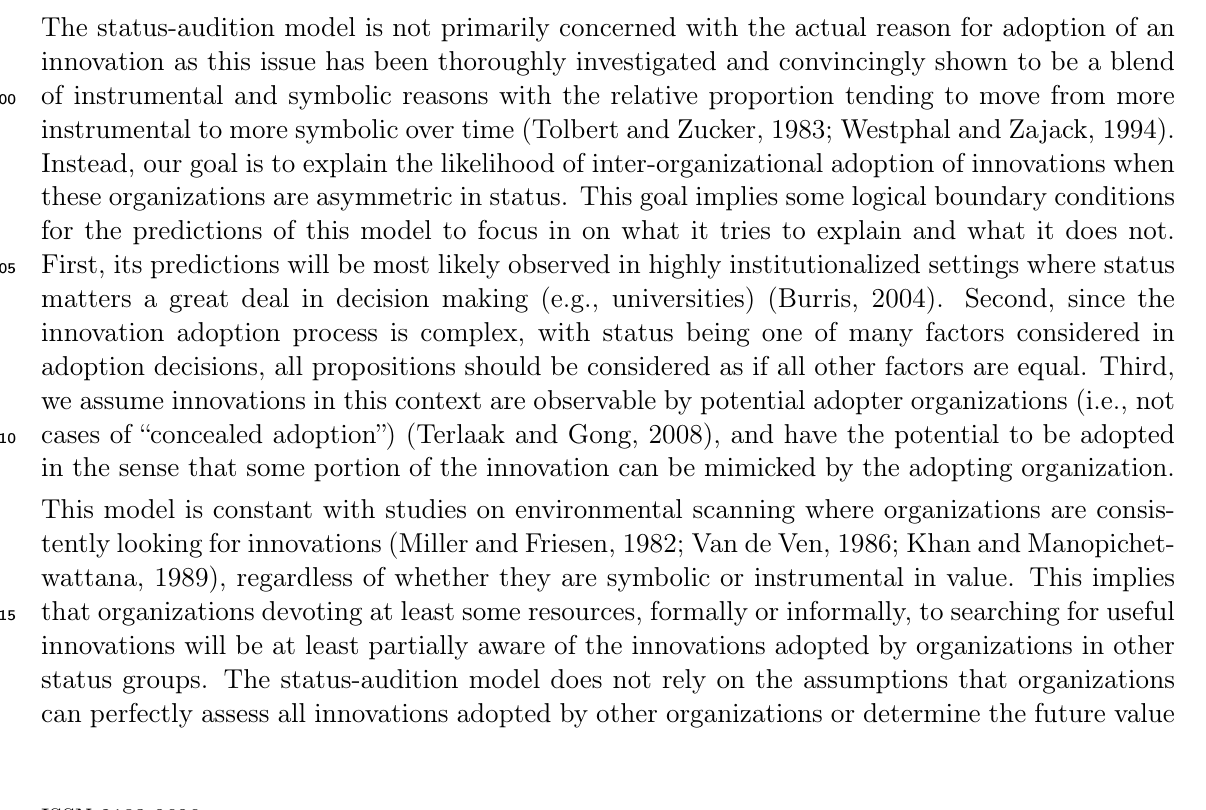
Fig. 1. Status-Audition Model (Partially Based on Phillips and Zuckerman’s Candidate- 295 Audience Interface model